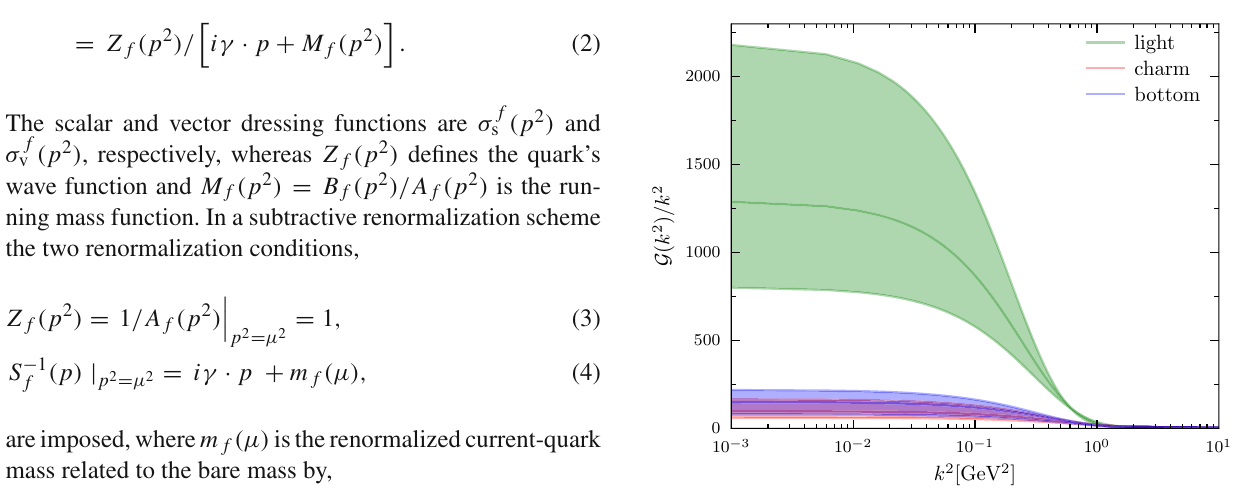
Fig. 1 The interaction function G ( k 2 )/ k 2 in Eq. (11) for different quark flavors and with ω f and κ f reported in Table 1. The shaded bands describe the model uncertainty in varying the interaction parameter ω f ; see Sect. 2.3 for